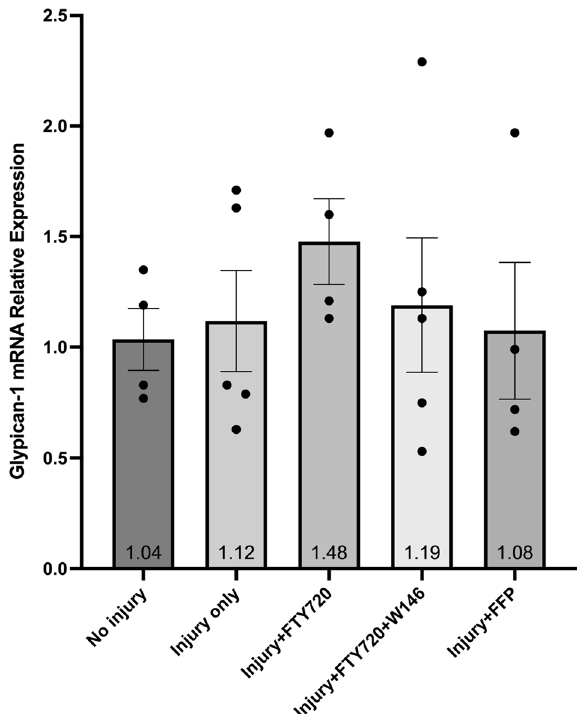
10 µ M of the sphingosine 1-phosphate receptor 1 (S1PR 1 ) antagonist W146, or fresh frozen plasma (FFP) on the relative expression of GP-1 mRNA from injured cultured human umbilical vein endothelial cells